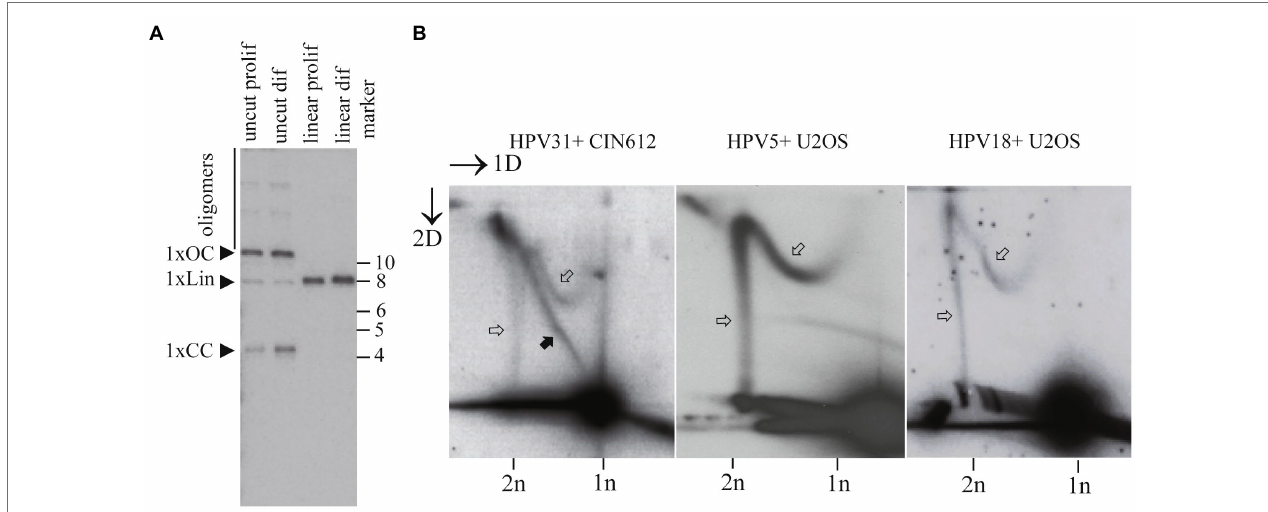
FIGURE 6 | Maintenance replication of the HPV31 genomes proceeds via distinct mechanisms in the CIN612 keratinocytes. (A) SB showing the status of the HPV31 genomes in CIN612 cells. HPV31 noncutter (BamHI) or single cutter (BstXI) enzymes were used to digest episomal DNA. Migration of the monomeric closed circular (1xCC), monomeric open circular (1XOC), linear (1xLin) and oligomeric forms are shown. (B) Neutral-neutral 2D analysis of the replication intermediates arising from the HPV31 maintenance replication in the CIN216 cells, HPV5 and HPV18 maintenance replication in the U2OS cells. Black arrows refer to the theta replication intermediates; white arrows refer to the non-theta replication